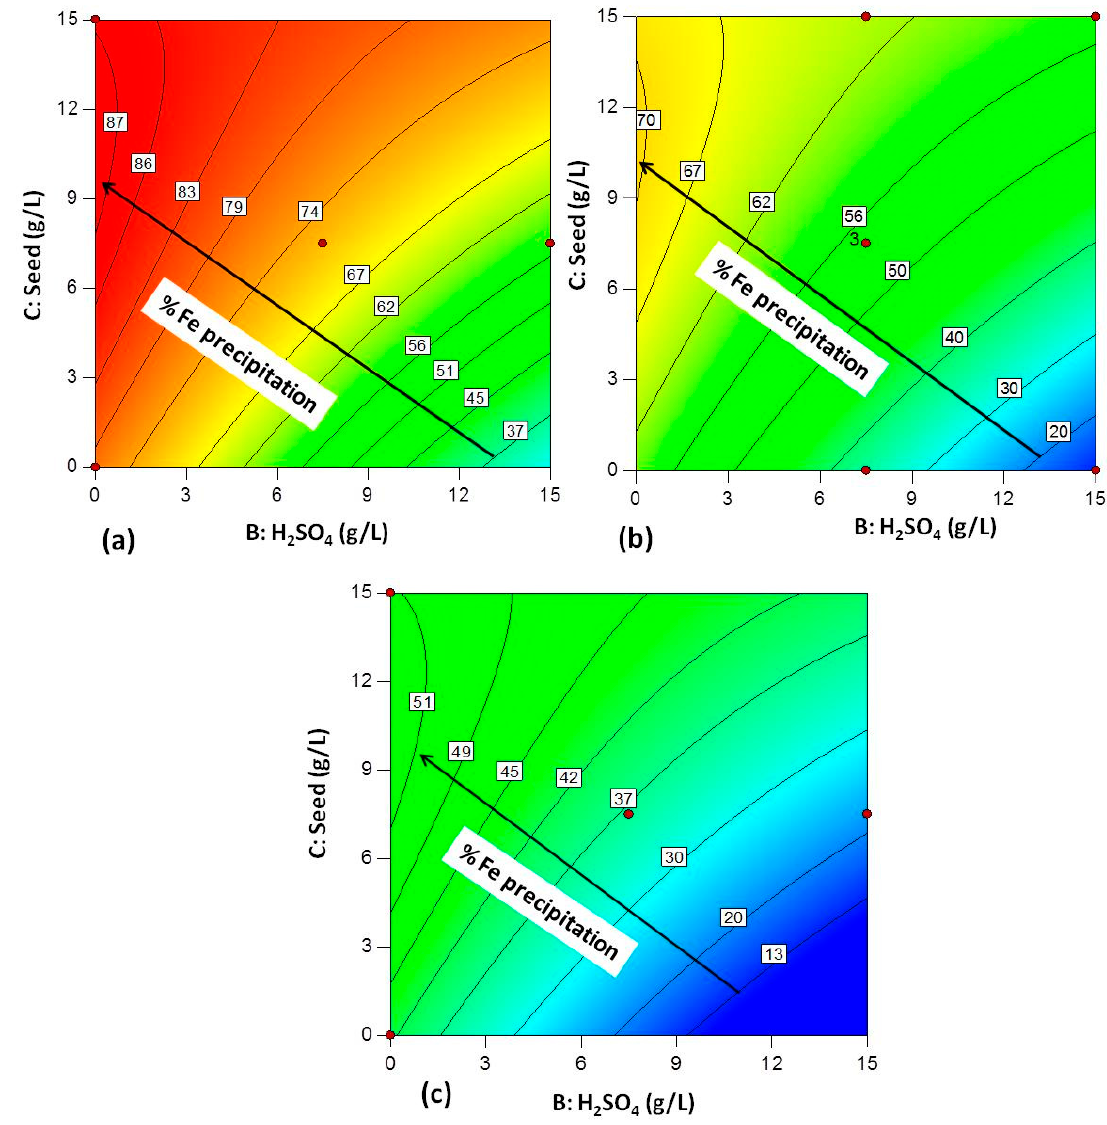
ff ects of initial H 2 SO 4 and seed concentrations on